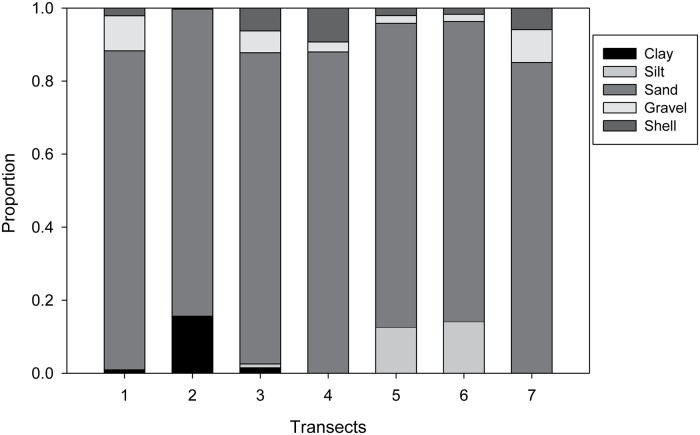
Proportions of sediments observed within CamSled Transects.Sediments were classified as clay, silt, sand, gravel and shell.